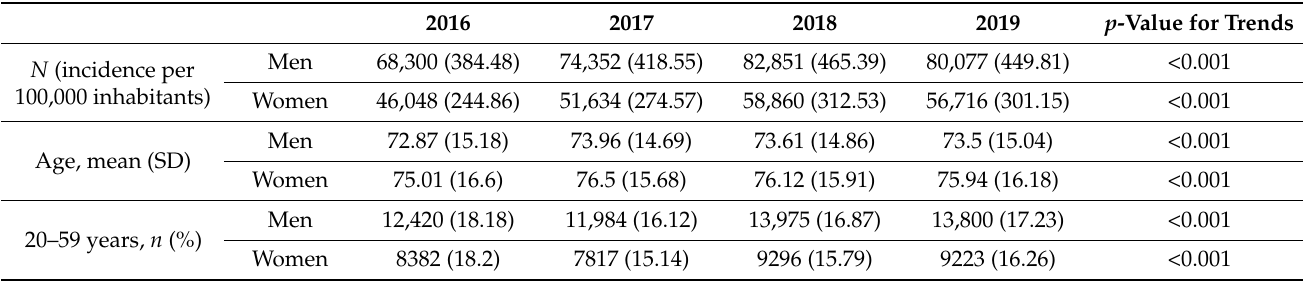
Table 1. Incidence, clinical characteristics and in-hospital outcomes of patients hospitalized with community-acquired pneumonia (CAP) in Spain from 2016 to 2019 according to